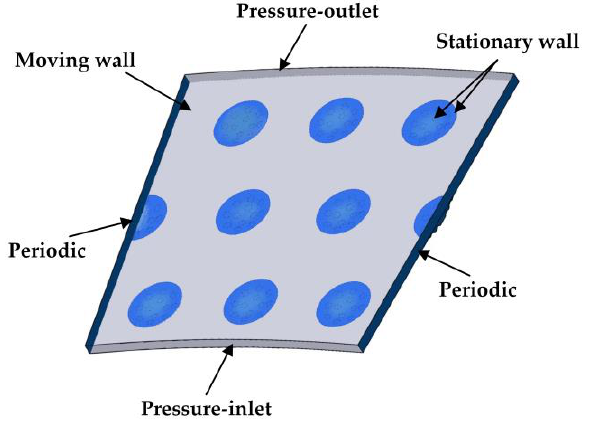
Figure 5. The setting of boundary conditions.